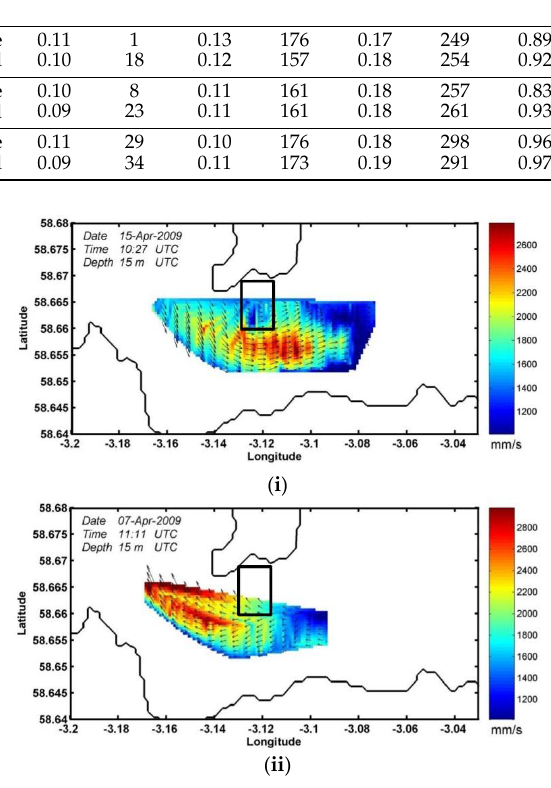
Figure 10. ADCP observations of tidal currents during flood ( i ) and ebb ( ii ) tides, from April 2009. The tidal currents were corrected for temporal distortion using a method described in [12], resulting in currents estimated at mid-track time. Study area marked with black